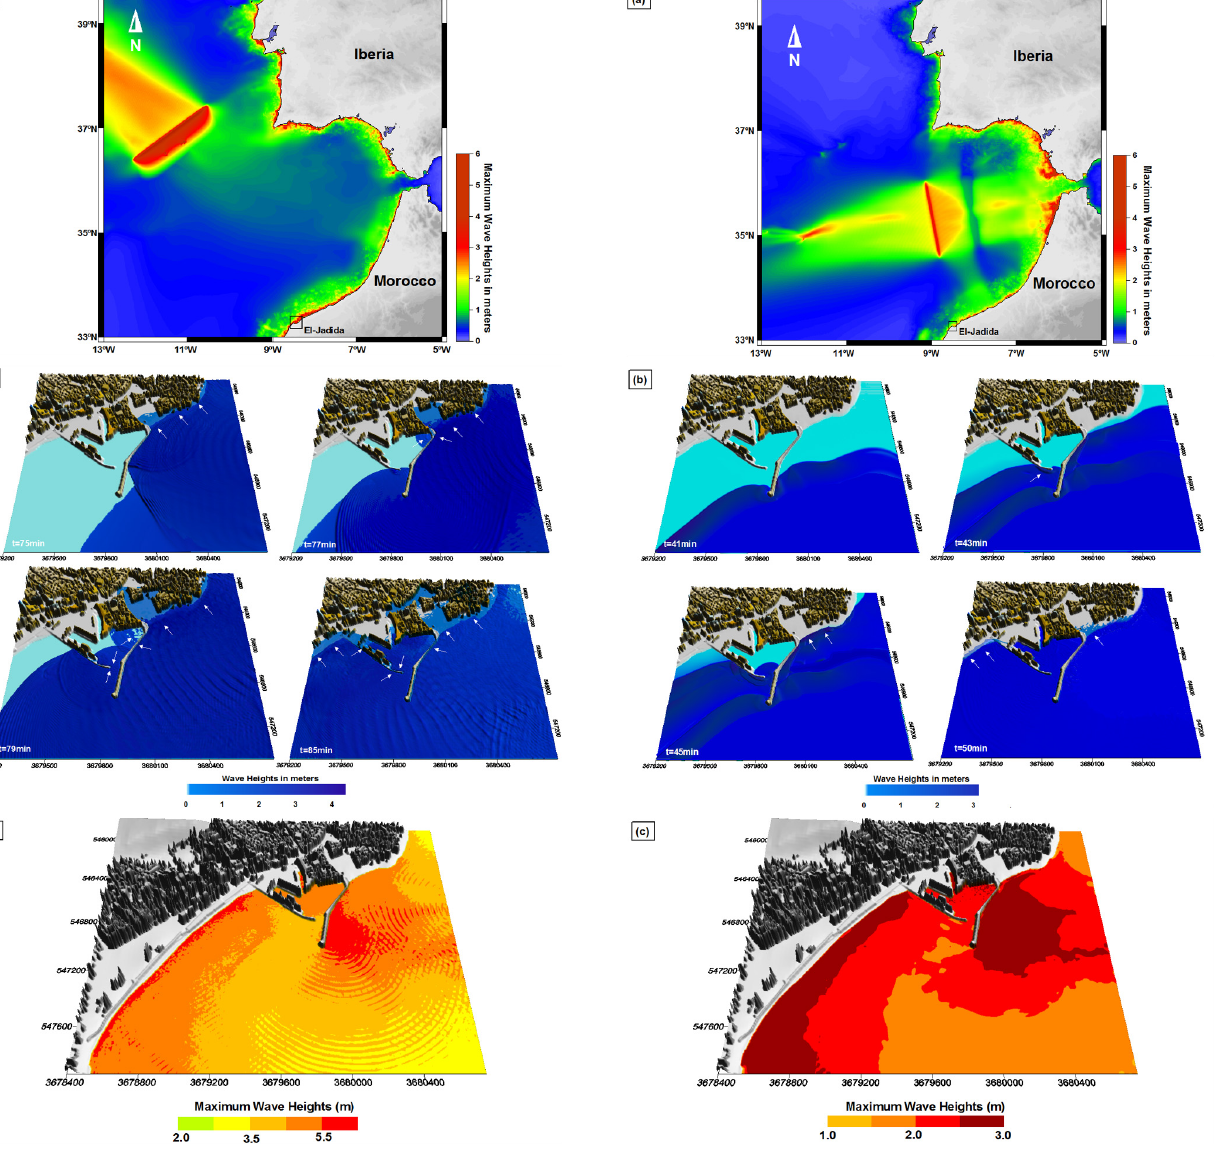
Fig. 9. Tsunami waves’ propagation and near-shore behaviour for the M w = 8 . 6 CW scenario: (a) regional tsunami energy patterns; (b) snapshots of near-shore tsunami propagation at El Jadida site; the white arrows indicate the overtopping locations; (c) maximum wave heights distribution near coasts and the harbour of the studied